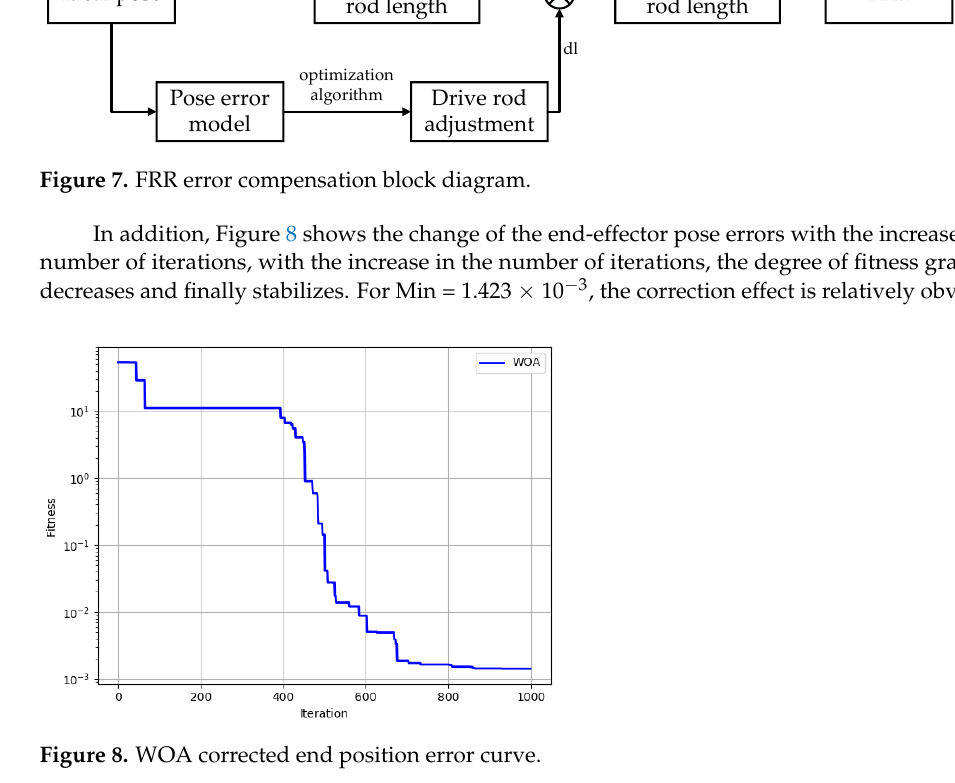
Figure 6. The whale optimization algorithm optimizes the process.